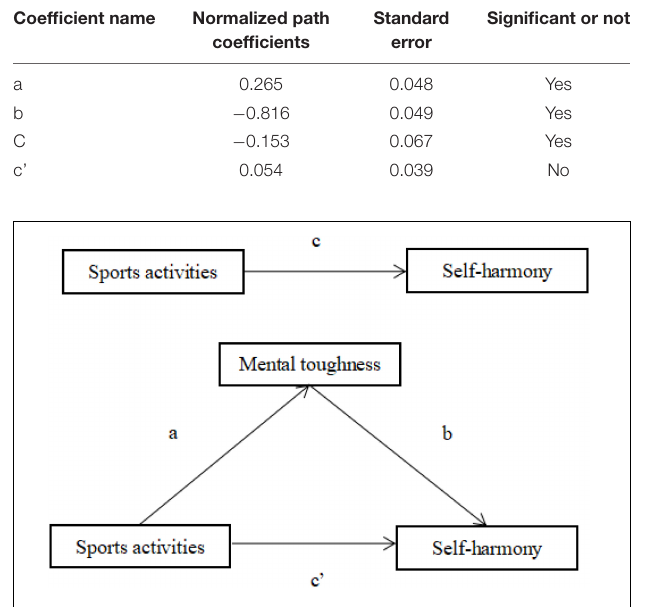
FIGURE 2 | Mediation equation model.